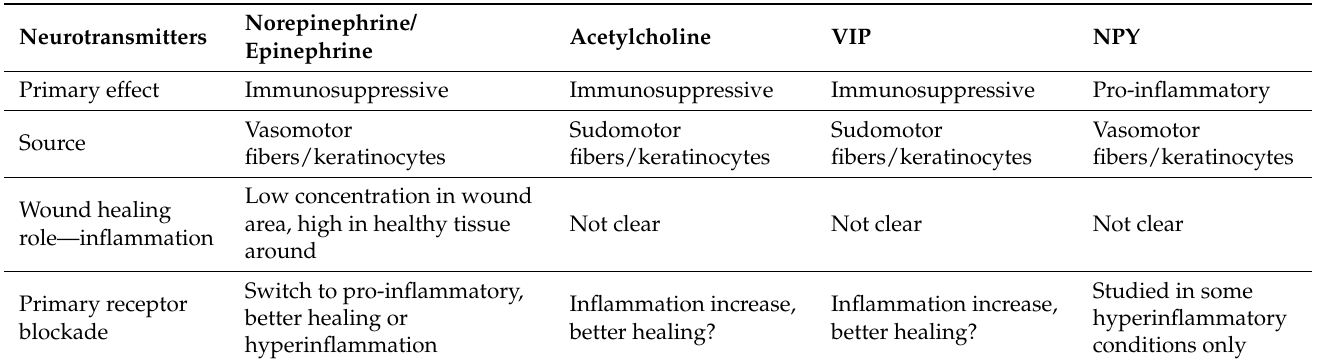
Table 1. Overview of sympathetic neurotransmitter interactions with immune